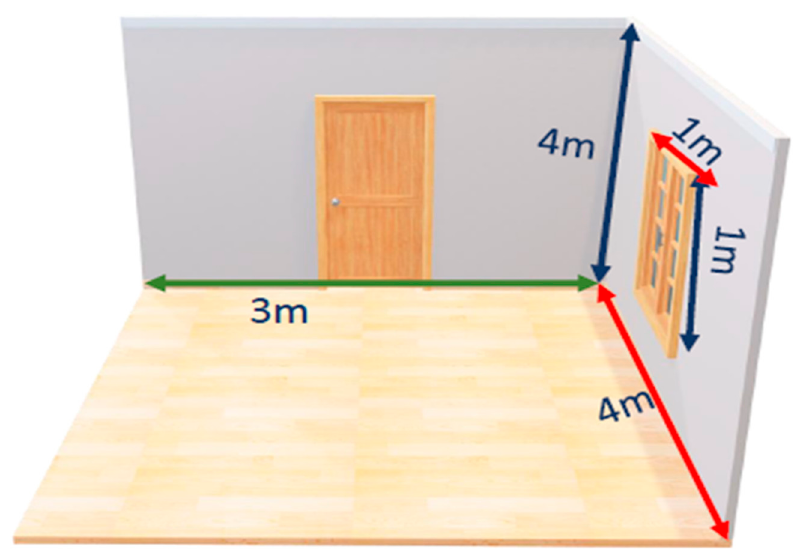
Figure 5. 3D View of thermal room.